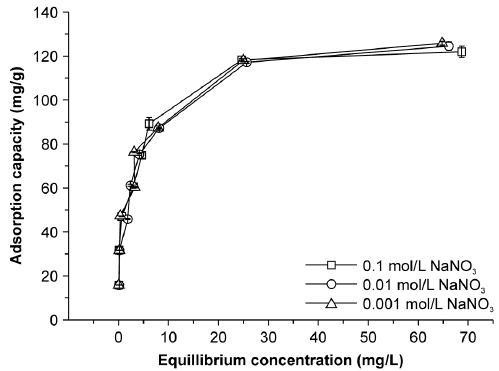
Figure 6. Effect of ionic strength on Cu(II) adsorption by NMBCs.